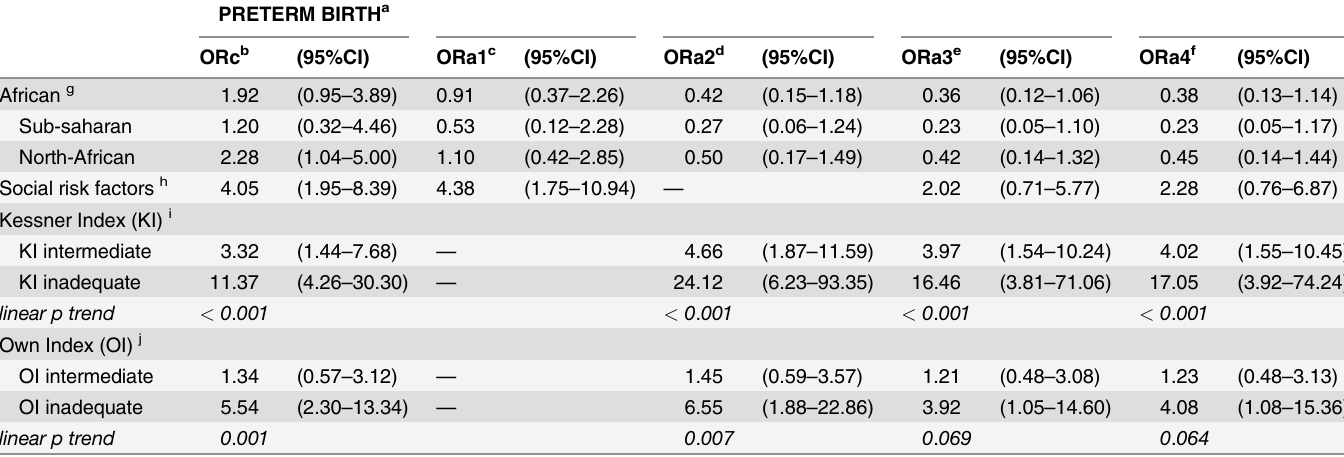
Table 2. Crude and adjusted associations between the immigrant status, other predefined variables (social risk factors and compliance with pre- natal care), and the risk of neonatal morbidity (preterm birth). PRETERM BIRTH